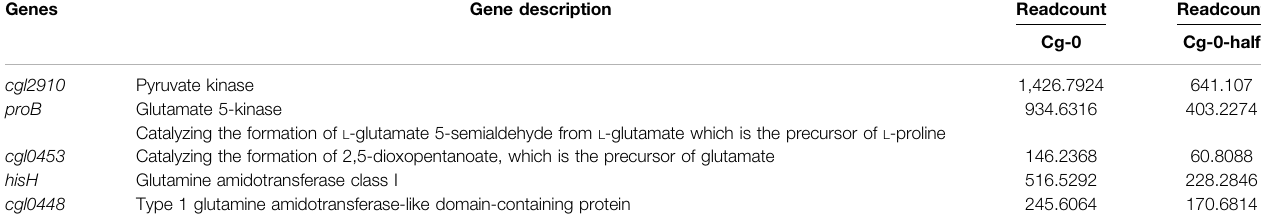
TABLE 2 | Identi fi ed key proteins with signi fi cant transcription difference in Cg-0 and Cg-0-half transcriptome. Genes